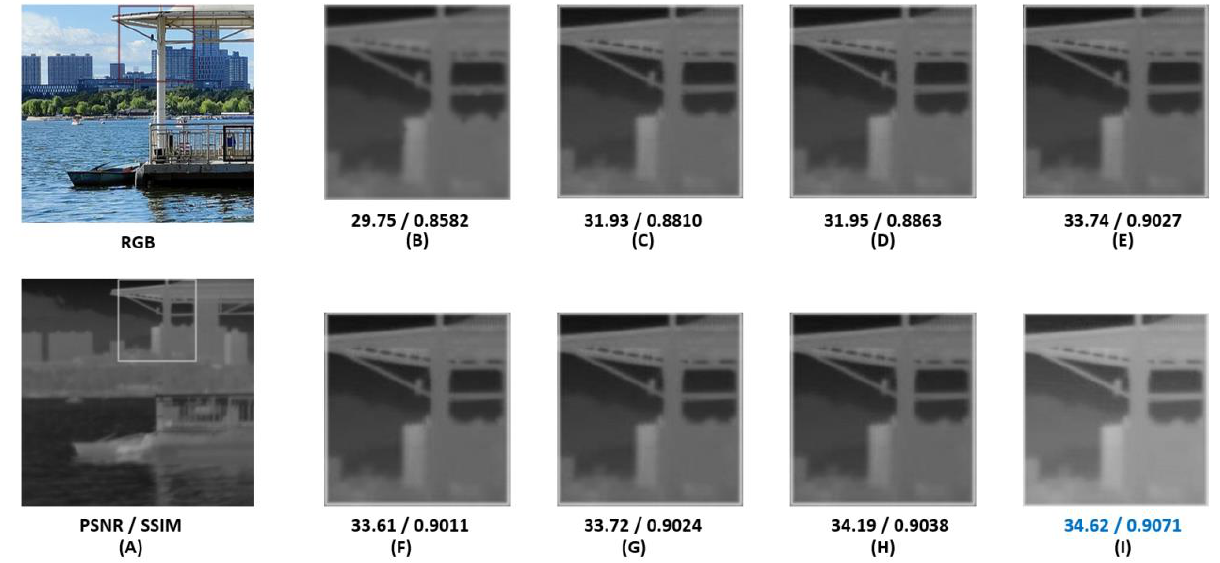
Figure 10. Comparison of restored results on dock by different super-resolution methods (3×). ( A )